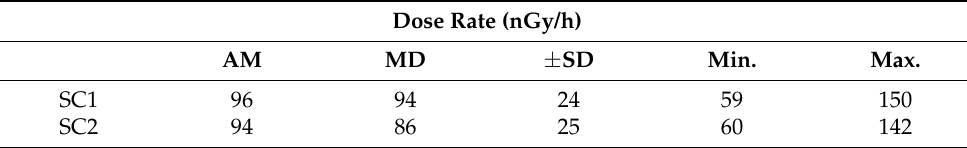
Table 2. Summary statistics for gamma dose rates (SC1 and